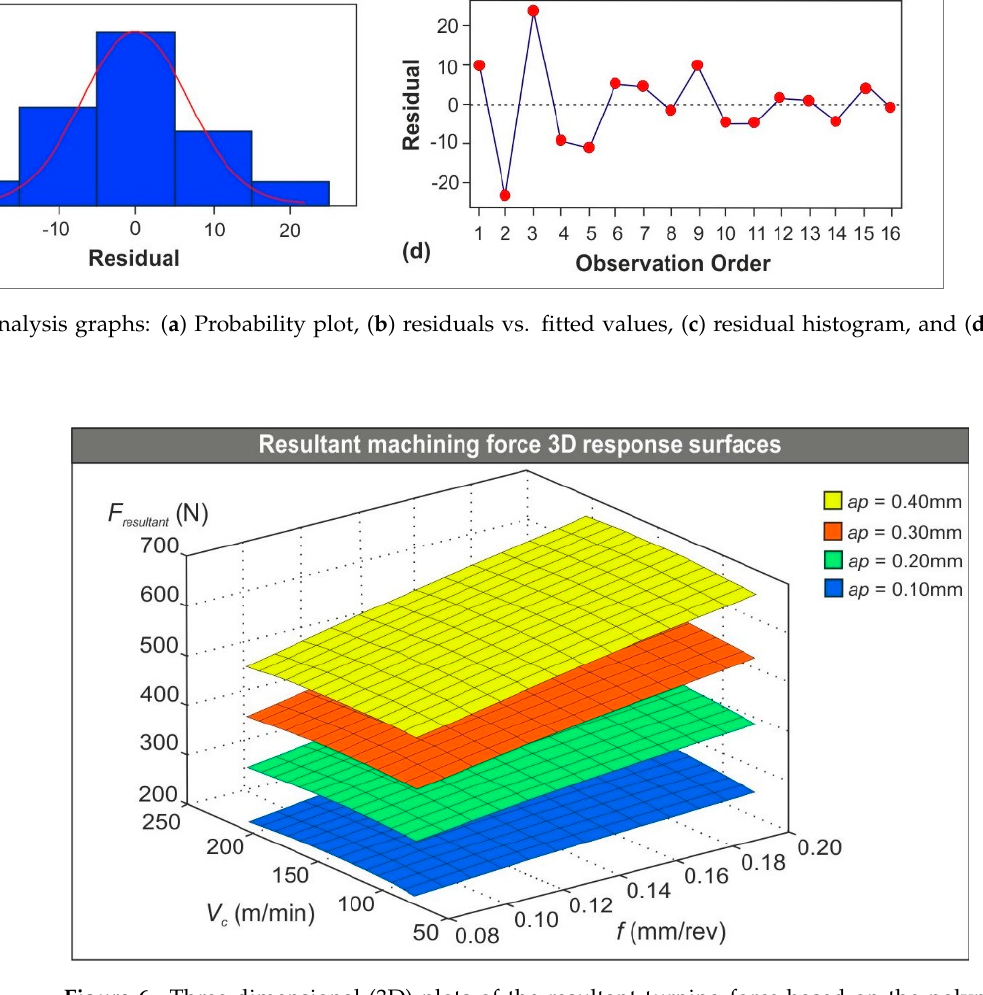
Figure 5. Residual analysis graphs: ( a ) Probability plot, ( b ) residuals vs. fitted values, ( c ) residual histogram, and ( d ) residuals vs. order.